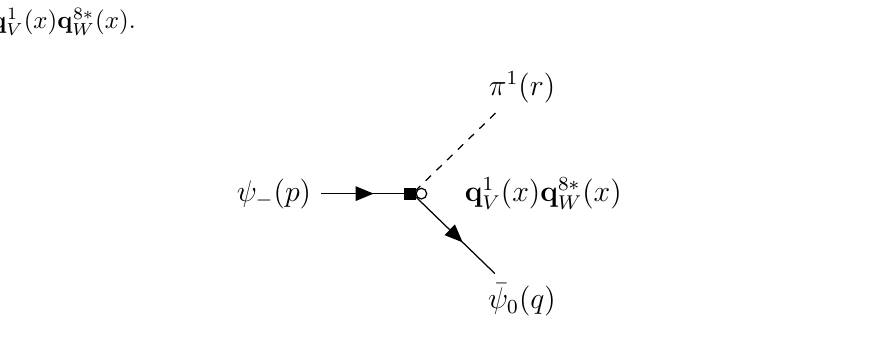
Figure 12 . The tree-level contribution to D V W in the Four-Fermi theory. The point (cid:4) vertice proportional to q 1